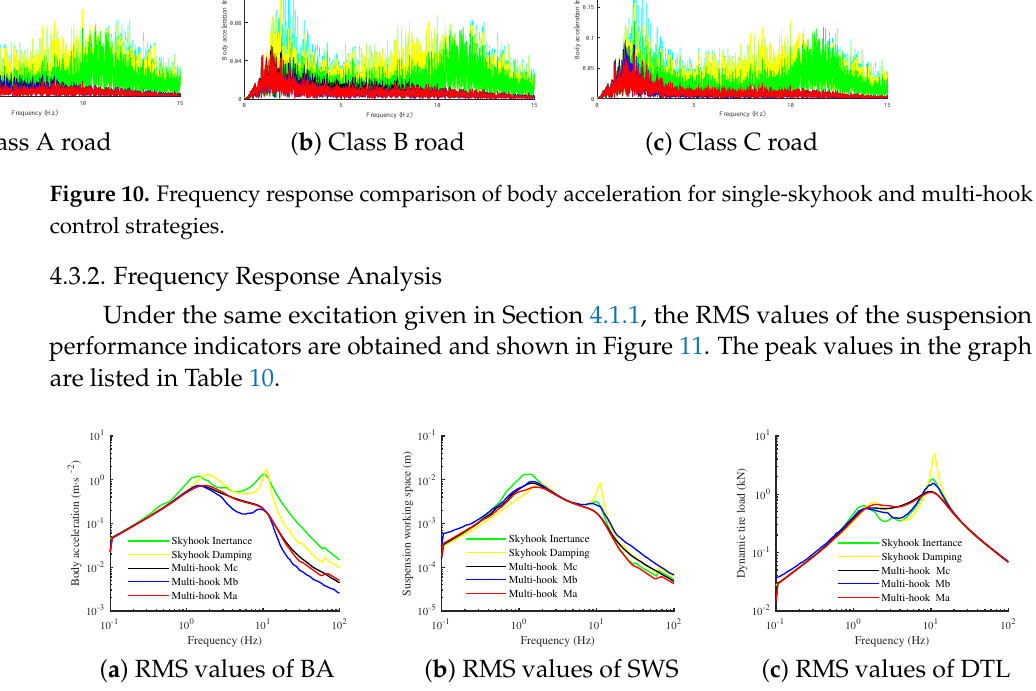
Figure 11. Frequency response comparison between single-skyhook and multi-hook control